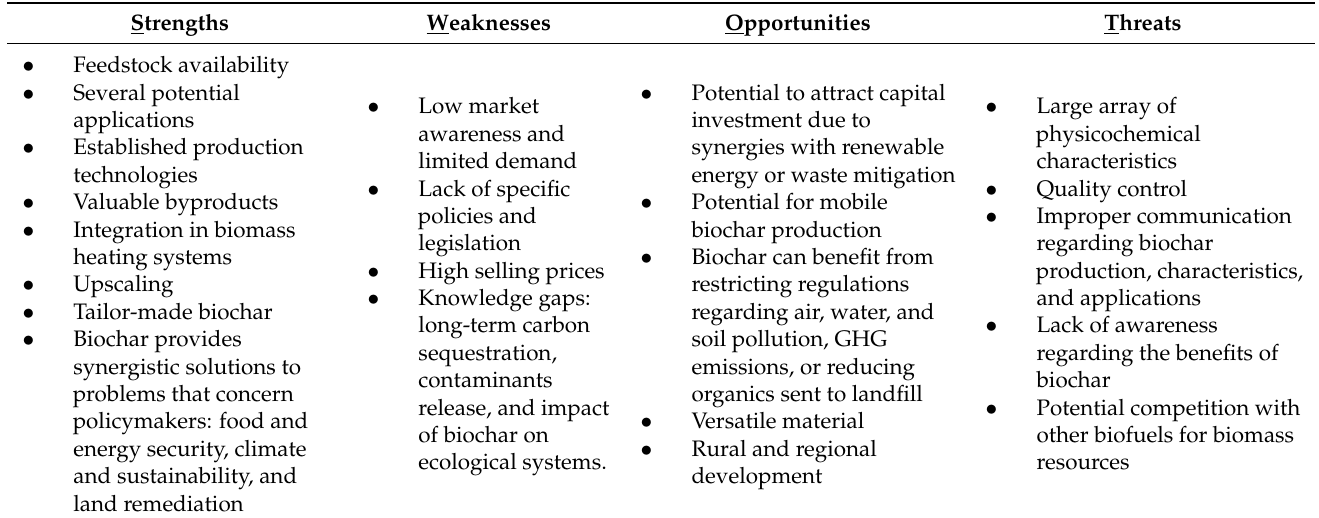
Table 12. SWOT analysis for developing the biochar industry in